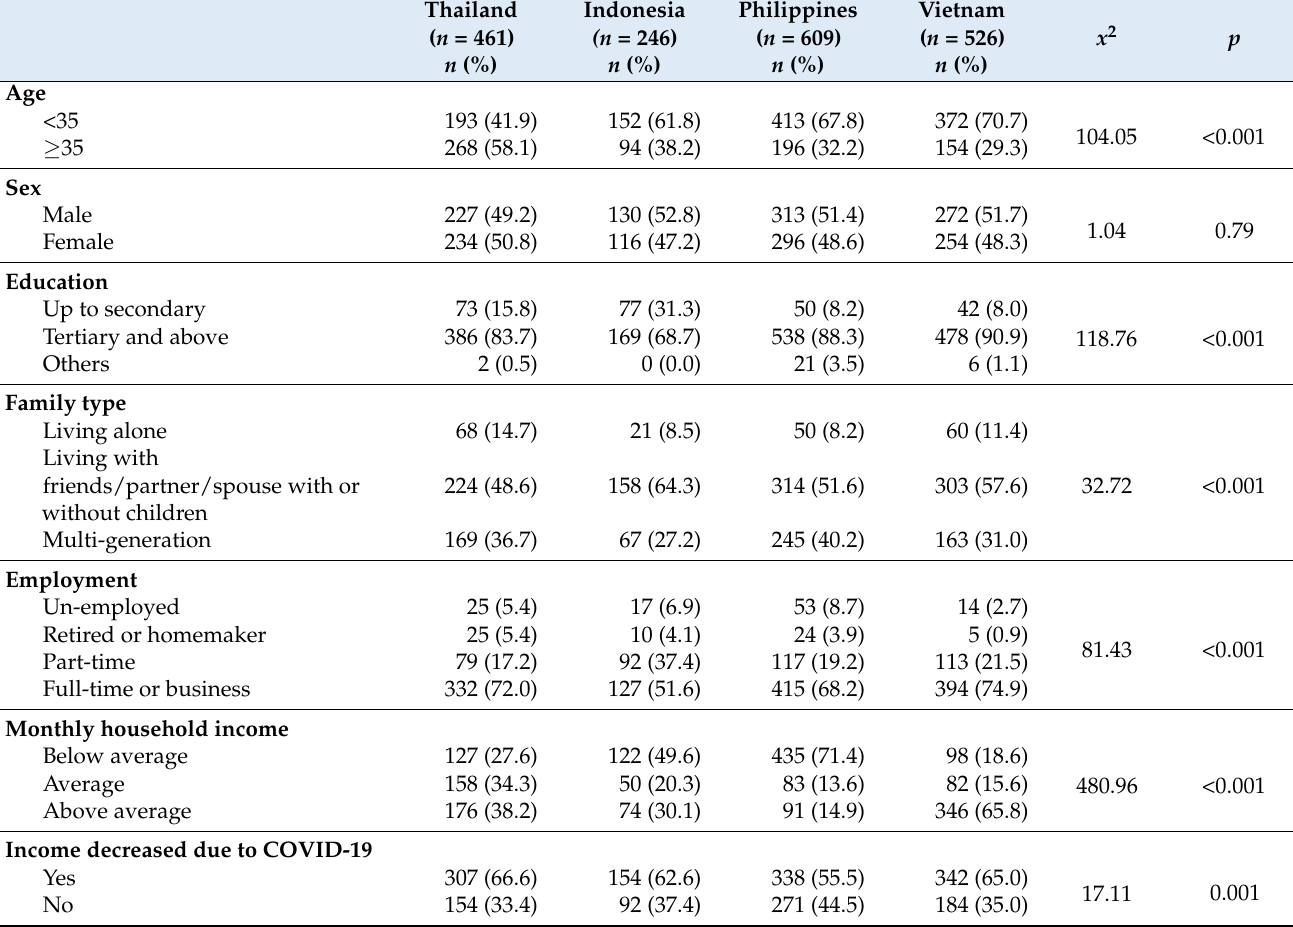
Table 3. Sociodemographic characteristics of the participants (have not yet been